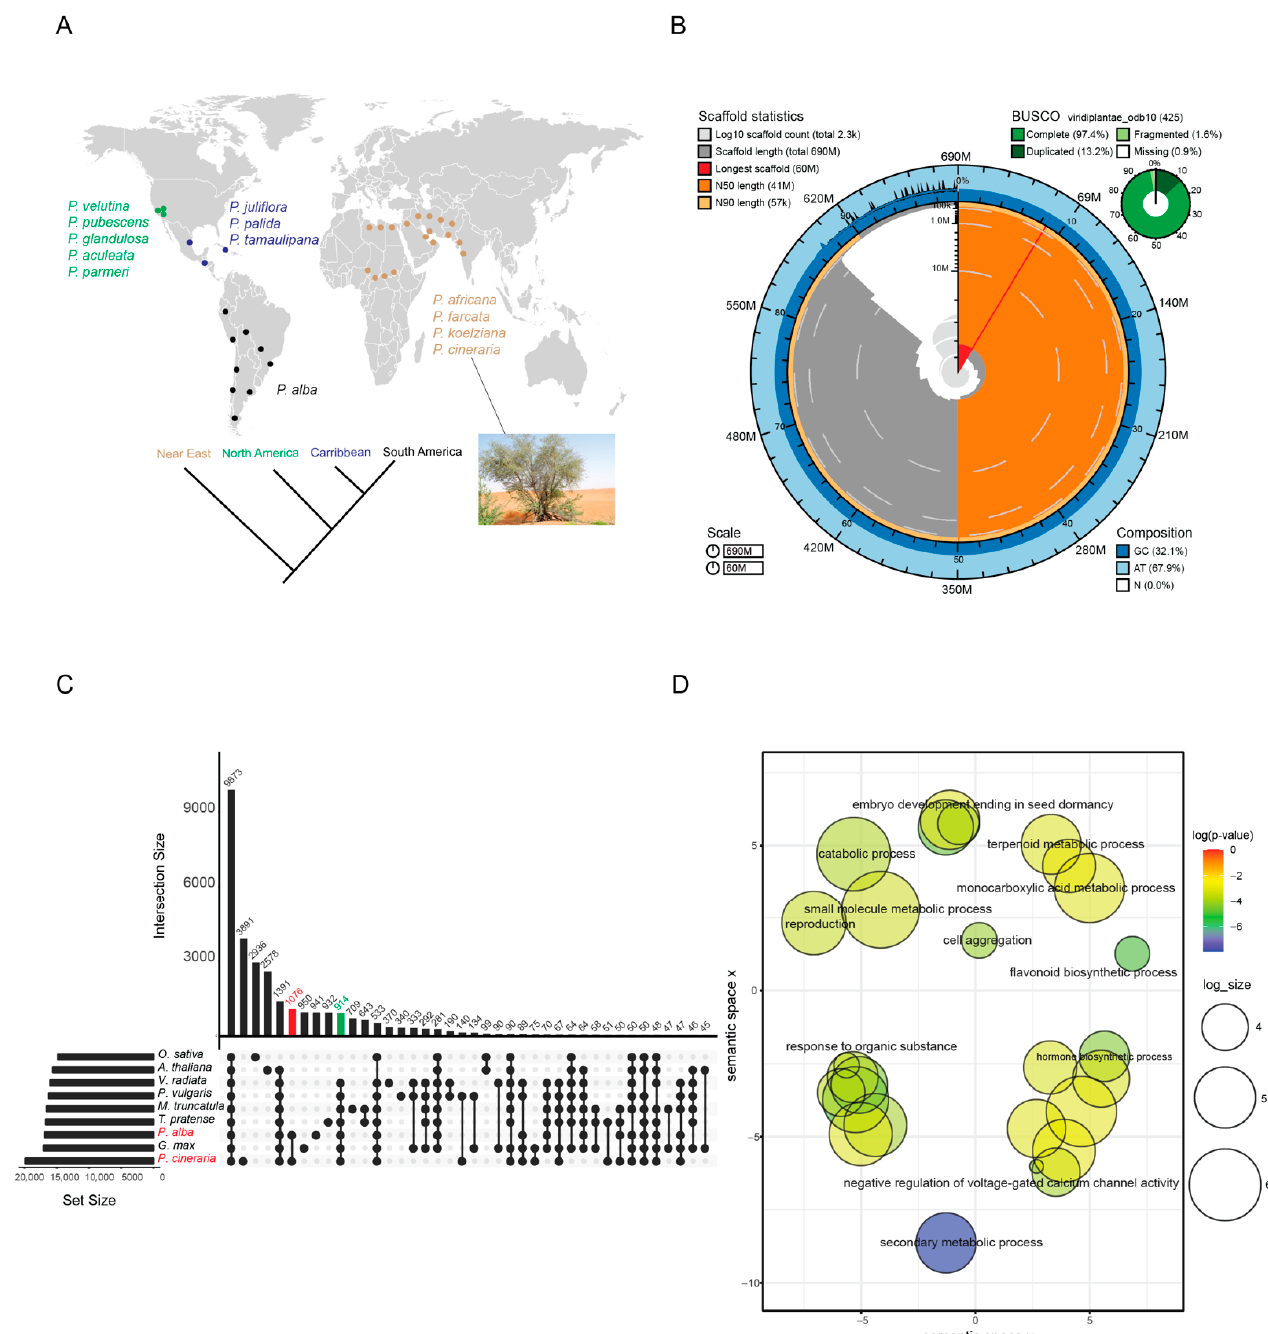
Figure 1. Distribution, genome assembly and orthology analysis of P. cineraria . ( A ) Geographic dis ‐ tribution of Prosopis species from around the world. P. cineraria is native to the Near East and Indian subcontinent, while other species are native to North and South America, and the Caribbean. ( B ) Blob Toolkit Snail plot describing assembly statistics. From inside to outside, cumulative scaffold count on log scale is depicted as light ‐ gray spirals, and the changes in order of magnitude with white scale lines. The dark ‐ gray segments show distribution of scaffold lengths, and the longest scaffold depicted in red was used to scale the plot radius. N50 and N90 scaffold lengths are high ‐ lighted in orange and light ‐ orange rings, respectively. Blue and light ‐ blue rings represent the per ‐ centages of GC, AT, and N in the genome assembly. ( C ) Orthologous group analysis of P. cineraria and P. alba from the mimosoid clade compared with other legumes are represented using UpsetR plot. Green bars represent groups shared with other legumes, while red bars are orthologous gene